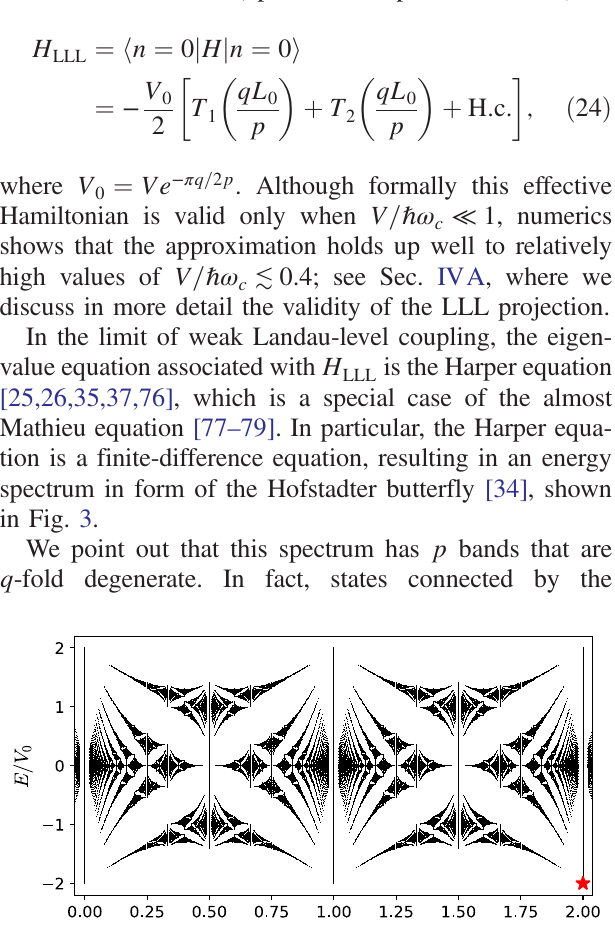
FIG. 2. Low-energy spectrum of the Hamiltonian in Eq. (21) as a function of the inverse flux ratio q=p for a fixed value of 0 . 4 . The initially flat Landau levels at E V= ℏ ω c ¼ 1 = 2 (obtained for V ¼ 0 ) are split into subbands dependent on k .